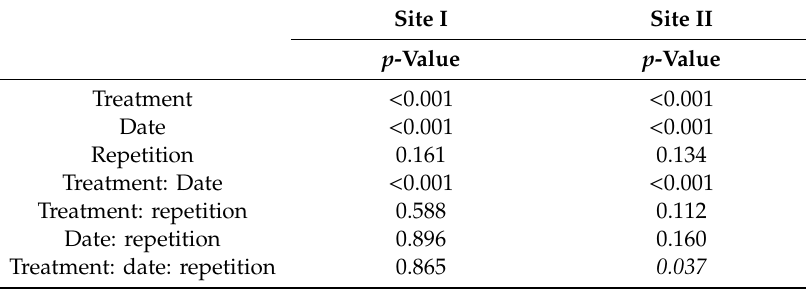
Table 1. Weed control type III analysis of variance with Satterthwaite’s method resulting from the linear mixed model where the treatments (control, flaming, glyphosate, hot foam, and nonanoic acid), evaluation date (one day before, and one and two days after the treatments) and repetition of the experiment (I and II) were used as fixed factors at sites I and II, respectively. Significant p -values are shown in italics.